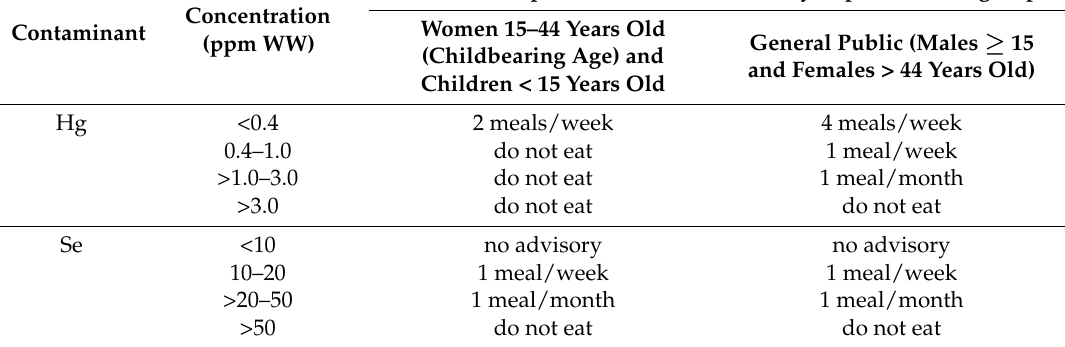
Table 1. Summary of freshwater fish consumption recommendations by population subgroup for Hg and Se measured in ppm wet weight (WW) in North Carolina, USA, at the time of fish collection in 2014 and 2016